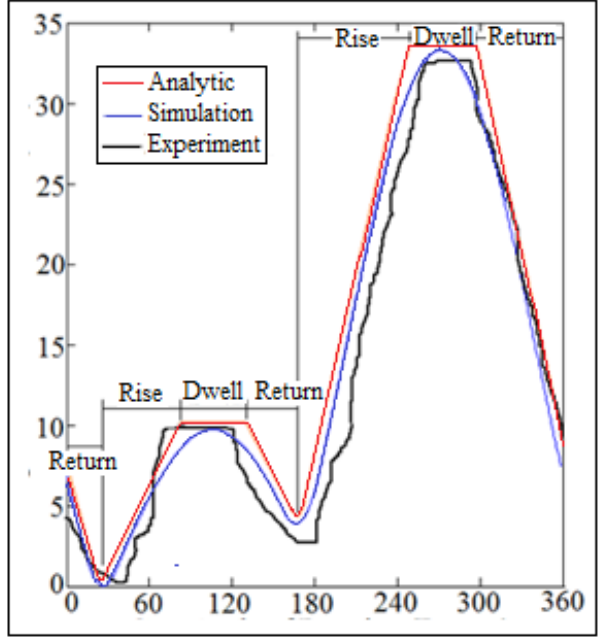
Figure 19. Comparison of nonlinear response of the follower.